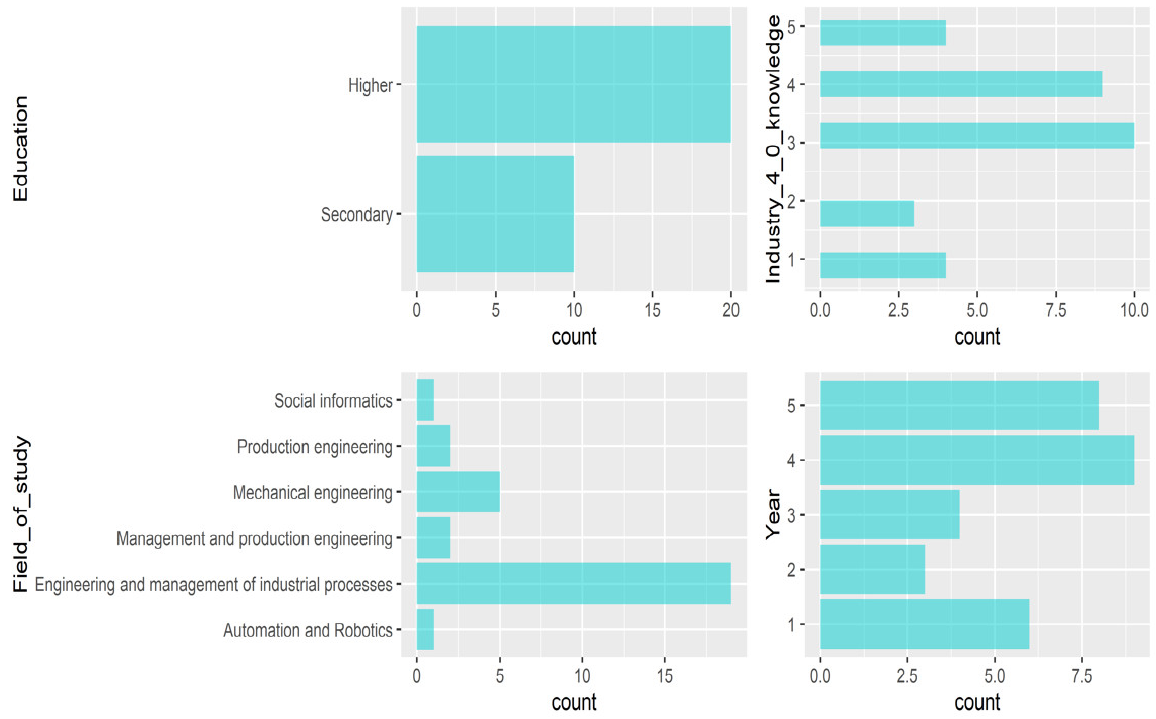
Figure 2. Characteristics of student trial. Source: own elaboration.